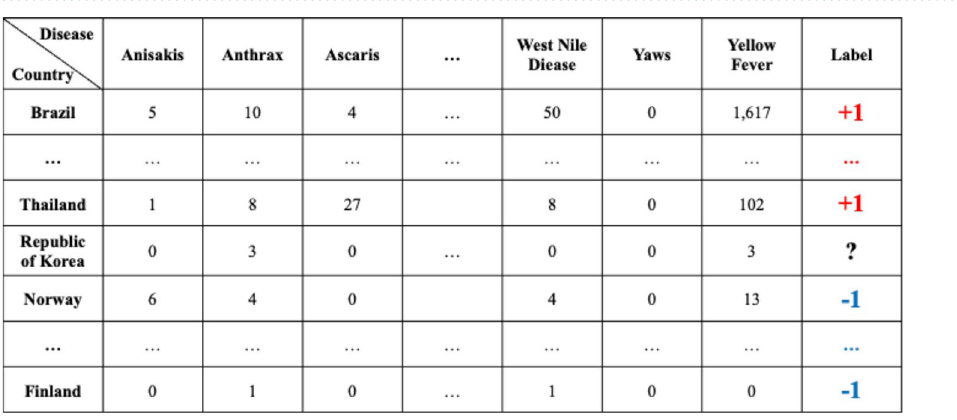
Figure 6. The overall data structure of each square shown in Fig.